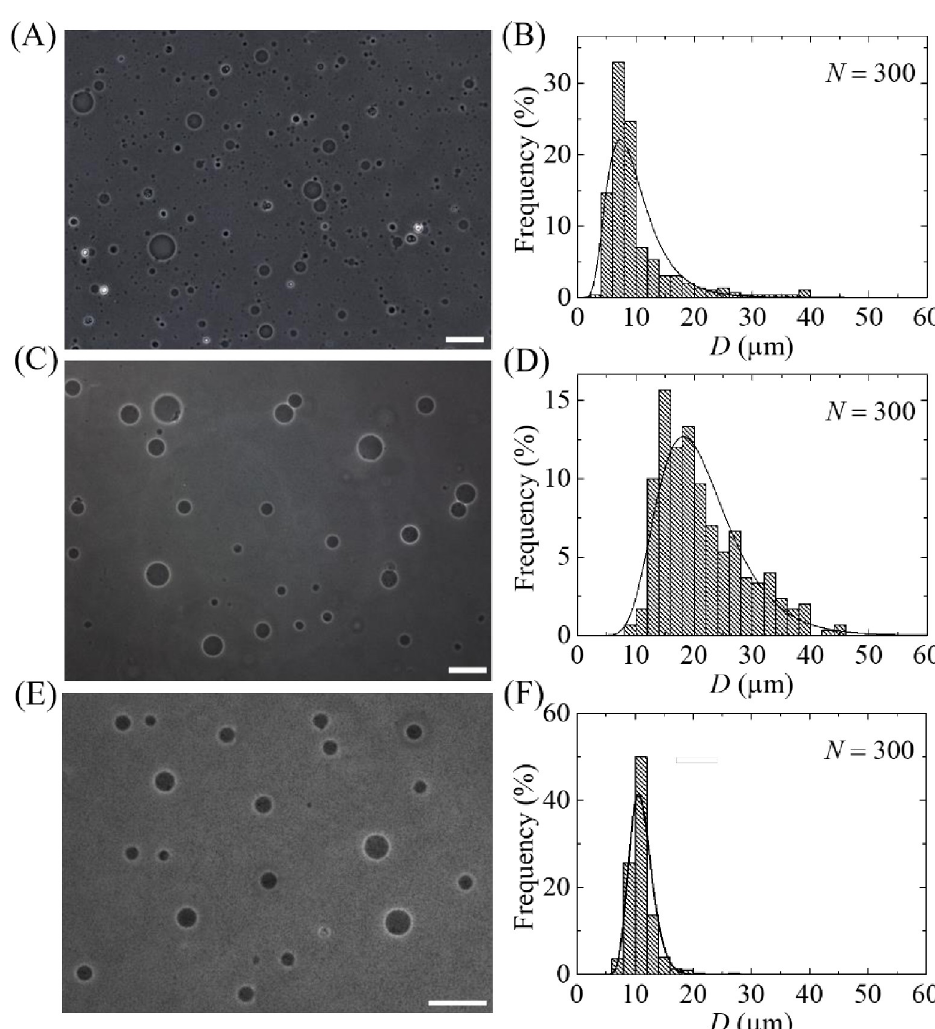
Fig 6. Effects of dual filtration with 12 and 10 μ m (case i) pores polycarbonate membranes on the size and distribution of 40%DOPG/60%DOPC-GUVs. (A) and (B) show the phase contrast image and the corresponding size distribution histogram of unpurified GUVs. (C) and (D) show the phase contrast image and the corresponding size distribution histogram of GUVs in filter holder 1. (E) and (F) show the phase contrast image and the corresponding size distribution histogram of GUVs in filter holder 2. The purification was performed at flow rate 1 mL/min for 1 h. The bar in the images (A, C, E) corresponds to a length of 50 μ m. The solid line of B, D and F corresponds to fitting with Eq